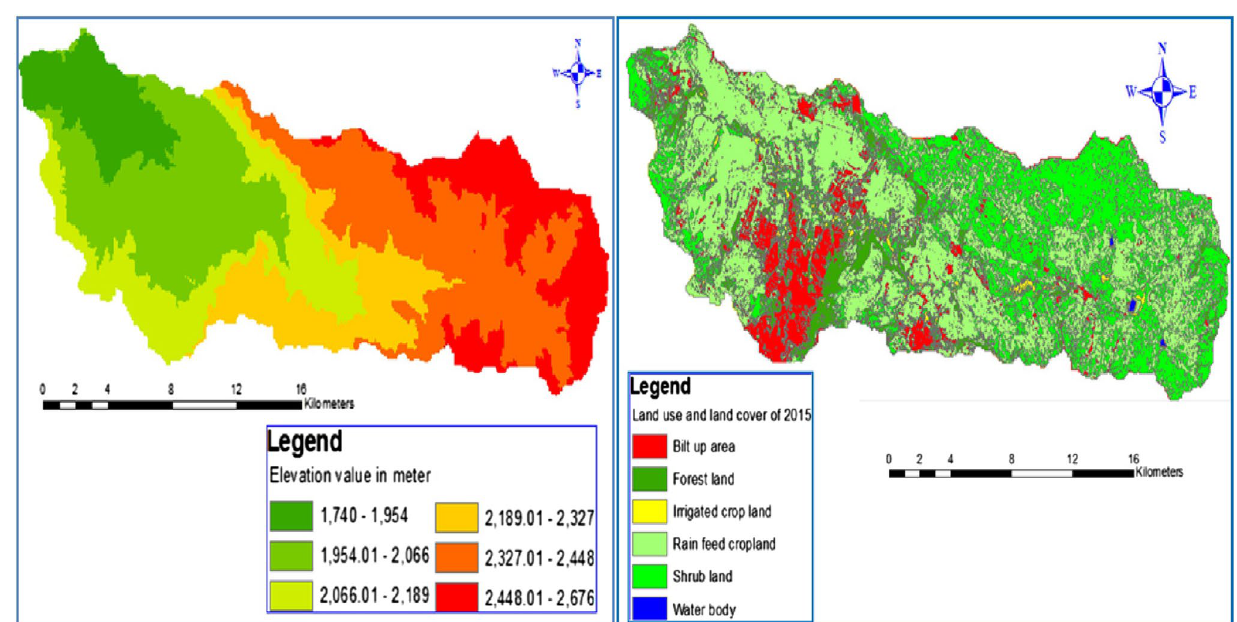
Fig. 2 Land cover and topographic map of the study